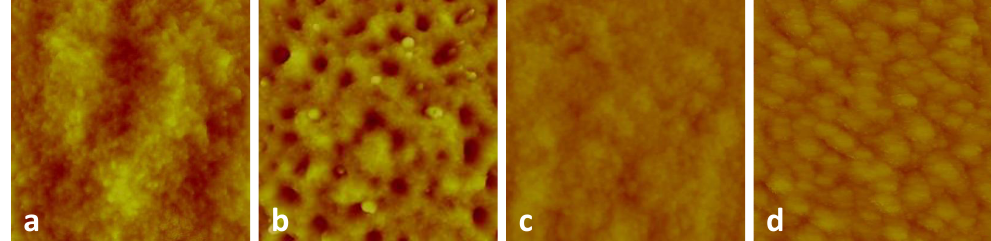
Figure 2. 3D- AFM images of 5 × 5 µ m scan area of the pure PQDs and PQDs/c-TiO 2 films deposited on glass substrate with various thicknesses ( a – d ) for 0, 10, 20, and 50 nm c-TiO 2 thickness